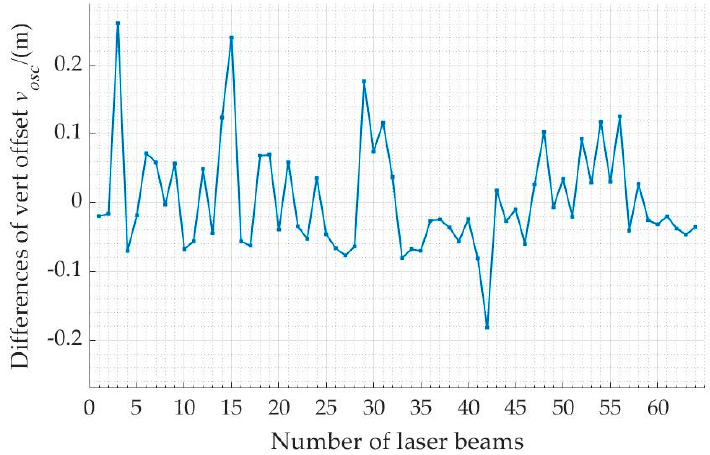
h . Figure 18. Differences in horizontal distance h osc _ i . _ osc i h . _ osc i